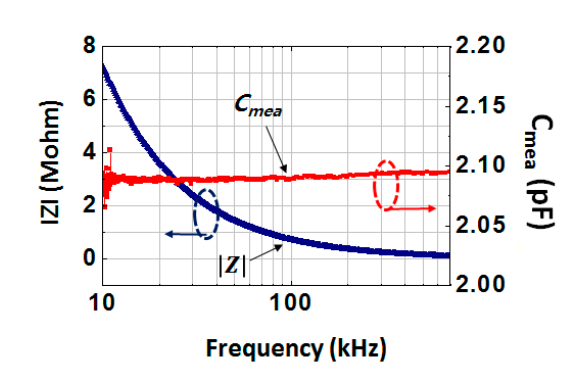
Figure 3. Measured capacitance and impedance data for the sensor used for extracting both the intrinsic and parasitic terms in the lumped equivalent circuit.